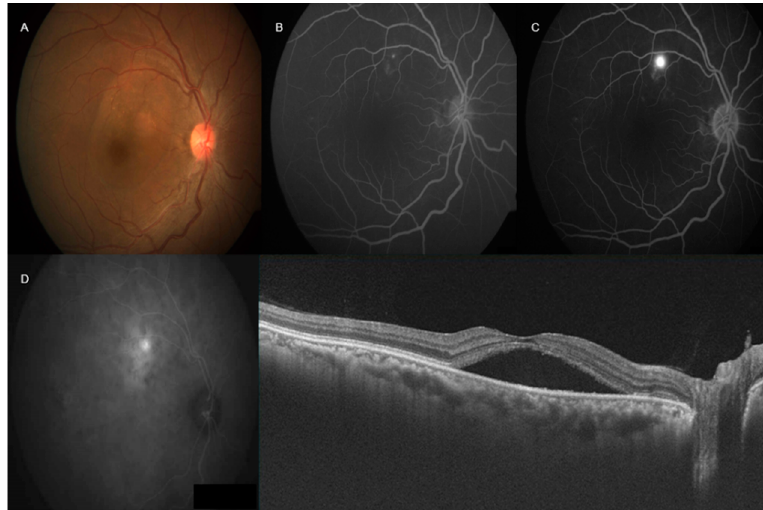
Figure 1. Multimodal imaging in central serous chorioretinopathy (CSCR)—right color fundus photograph ( A ) showed pocket of subretinal fluid involving fovea. Fluorescein angiography (FA) ( B , C ) showed ink-blot leakage superior to fovea. Indocyanine green angiography (ICGA) showed increased fluorescence with focal late leakage superior to the fovea ( D ). Swept source optical coherence tomography showed neurosensory detachment involving fovea with increased subfoveal choroidal thickness.